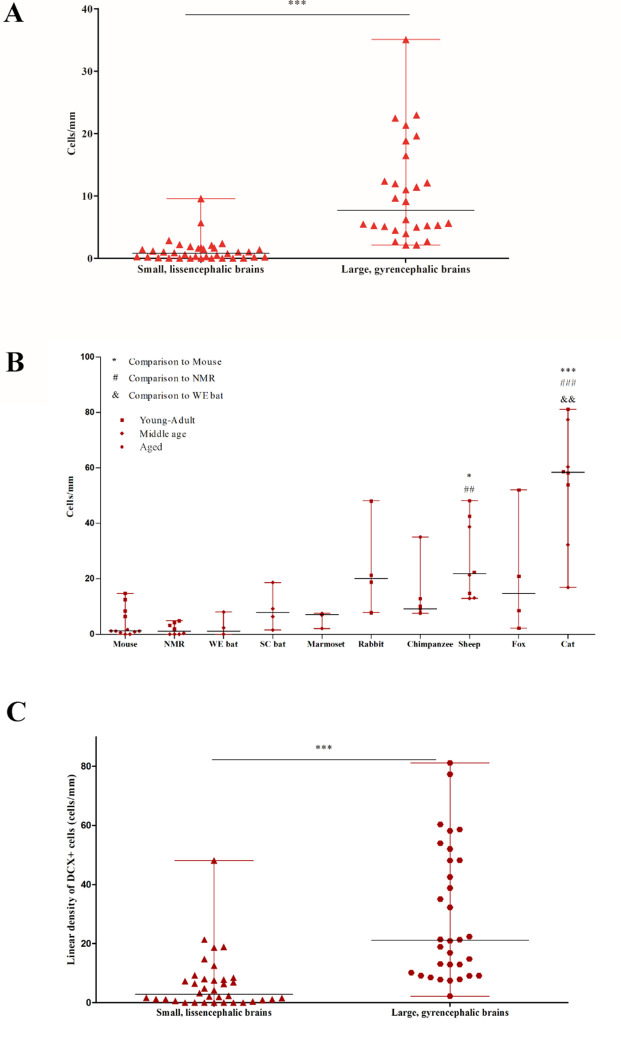
Quantification of DCX+ cINs density in the mammalian cortex.(A) Total linear density of DCX+ cells in small, lissencephalic brains compared to large, gyrencephalic brains. Each data point represents the average DCX+ cell density from an individual brain in the sample. A high degree of heterogeneity is observed. (B) Linear density of DCX+ cells in paleocortex. There is a high heterogeneity in adults among all species. (C) Paleocortical linear density of DCX+ cells in small, lissencephalic brains compared to large, gyrencephalic brains.